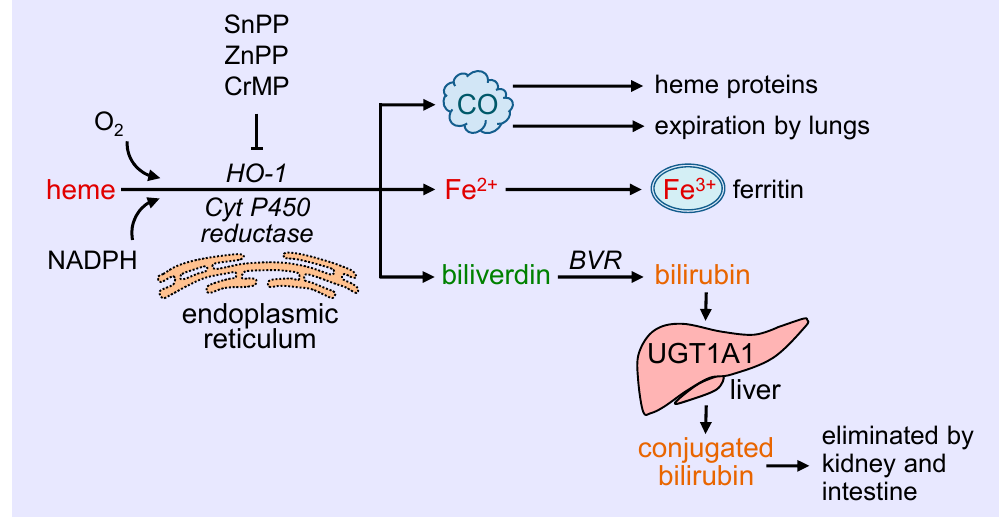
Figure 1. Schematic representation of the metabolism of heme. Heme is metabolized at the endoplasmic reticulum via the concerted action of heme oxygenase-1 (HO-1) and cytochrome P450 (Cyt P450) reductase to carbon monoxide (CO), ferrous iron (Fe 2+ ), and biliverdin. The generated CO interacts with intracellular heme proteins or diffuses to the circulation and is transported to the lungs and cleared by exhalation. Fe 2+ is rapidly sequestered by ferritin and stored in ferric (Fe 3+ ) form, while biliverdin is converted to bilirubin by biliverdin reductase (BVR). Ferritin is found in the cytosol of most tissues, but a small fraction is secreted into the blood where it functions as an iron carrier. Bilirubin is removed from the circulation by the liver and metabolized by uridine 5 ′ -diphospho-glucuronlytransferase 1A1 (UGT1A1) to water-soluble conjugated bilirubin for elimination by the intestine and kidney. The oxidative degradation of heme is prevented by various metalloporphyrins, including tin protoporphyrin (SnPP), zinc protoporphyrin (ZnPP), and chromium mesoporphyrin (CrMP).